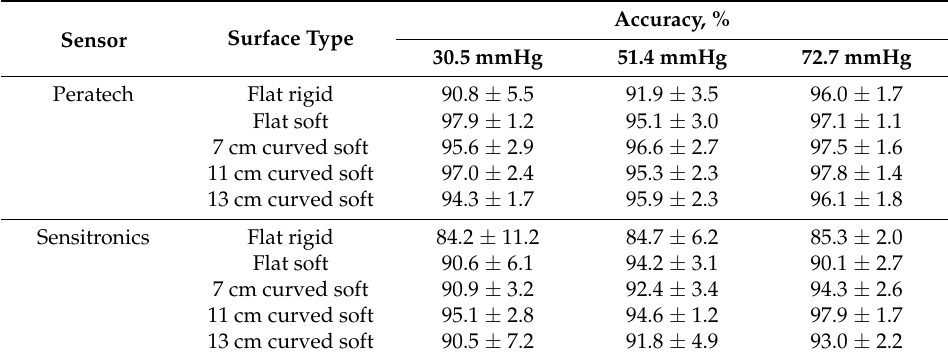
Figure 10. Dynamic testing results for Sensitronics sensor with applied pressure shown in the title: ( a – c ) sensor output voltage reading; ( d – f ) sensor pressure reading when sensor is recalibrated before each test. Dotted lines show corresponding applied gold standard pressures; ( g – i ) accuracy of the sensor pressure reading. Table 3. Average accuracy in dynamic pressure measurements.